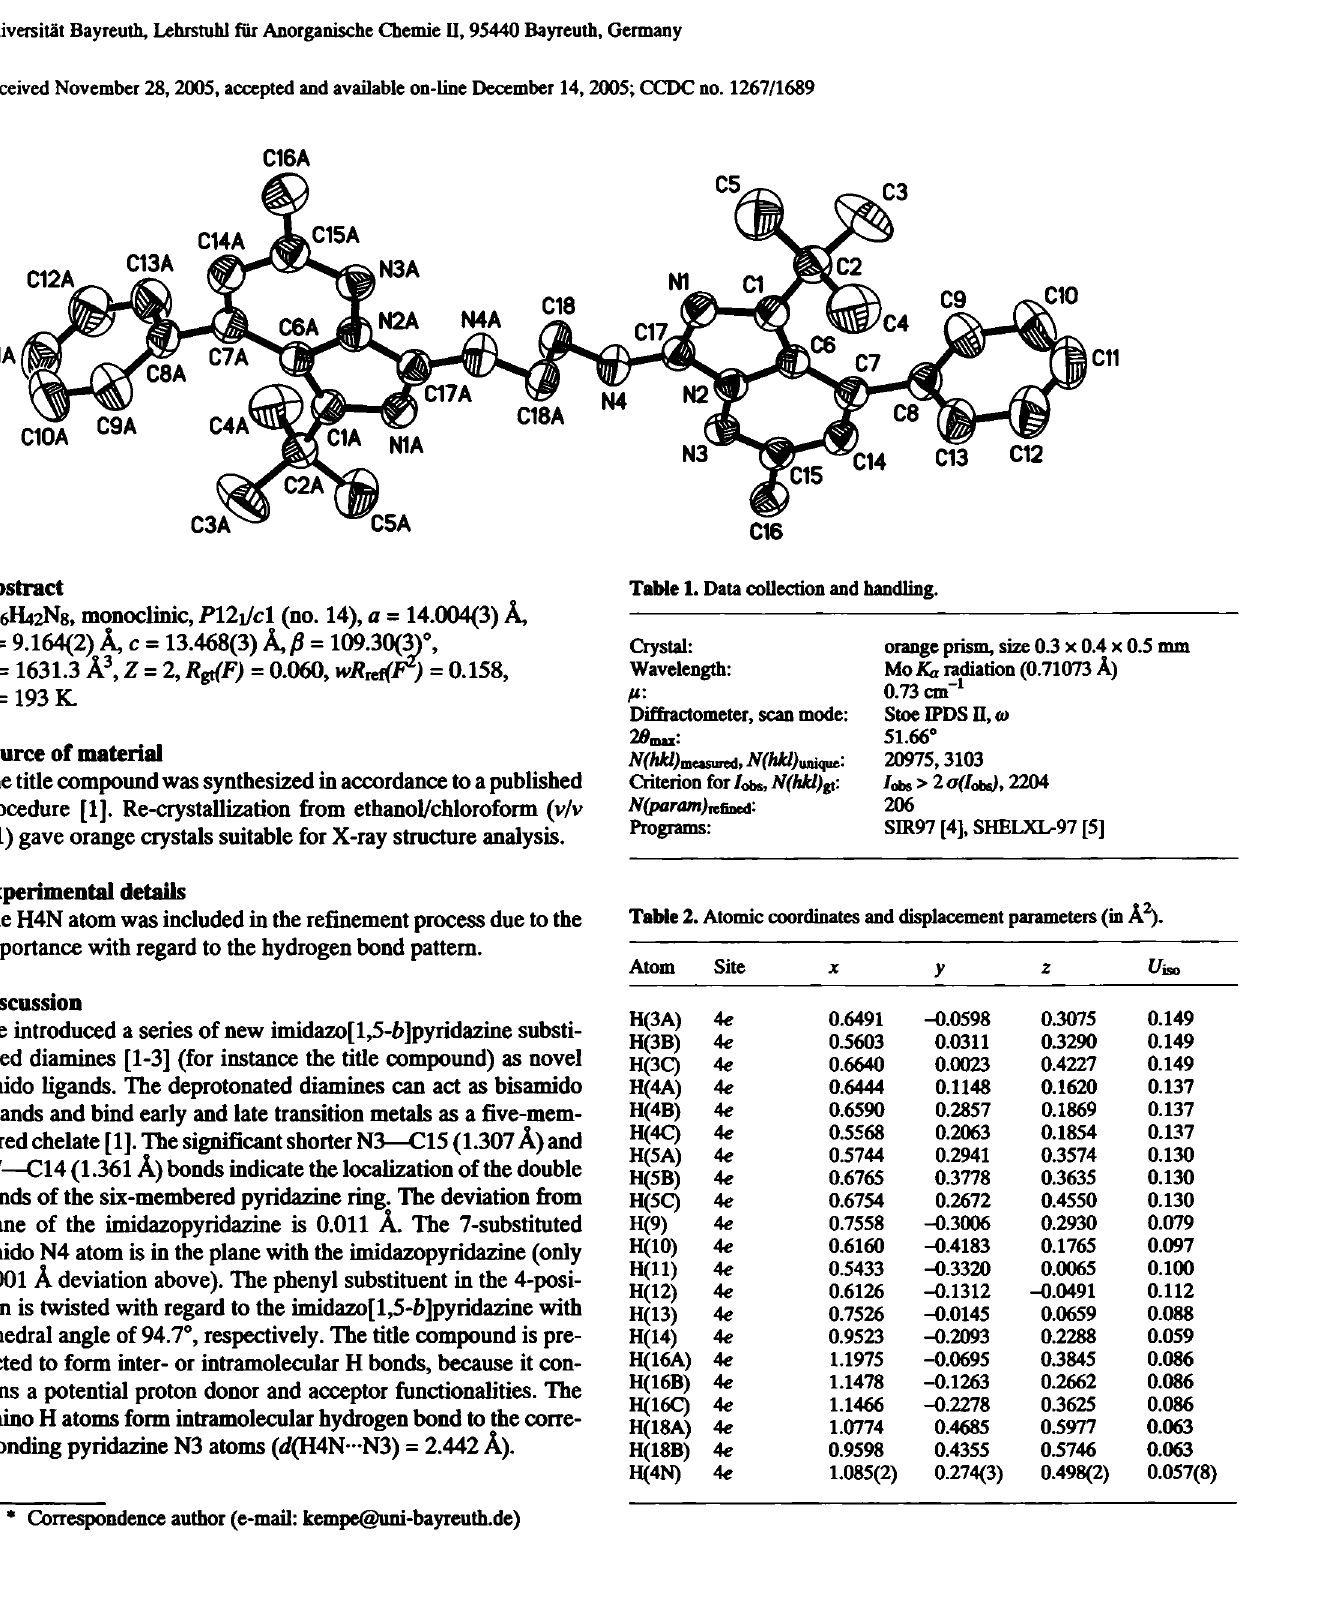
Table 1. Data collection and handling.